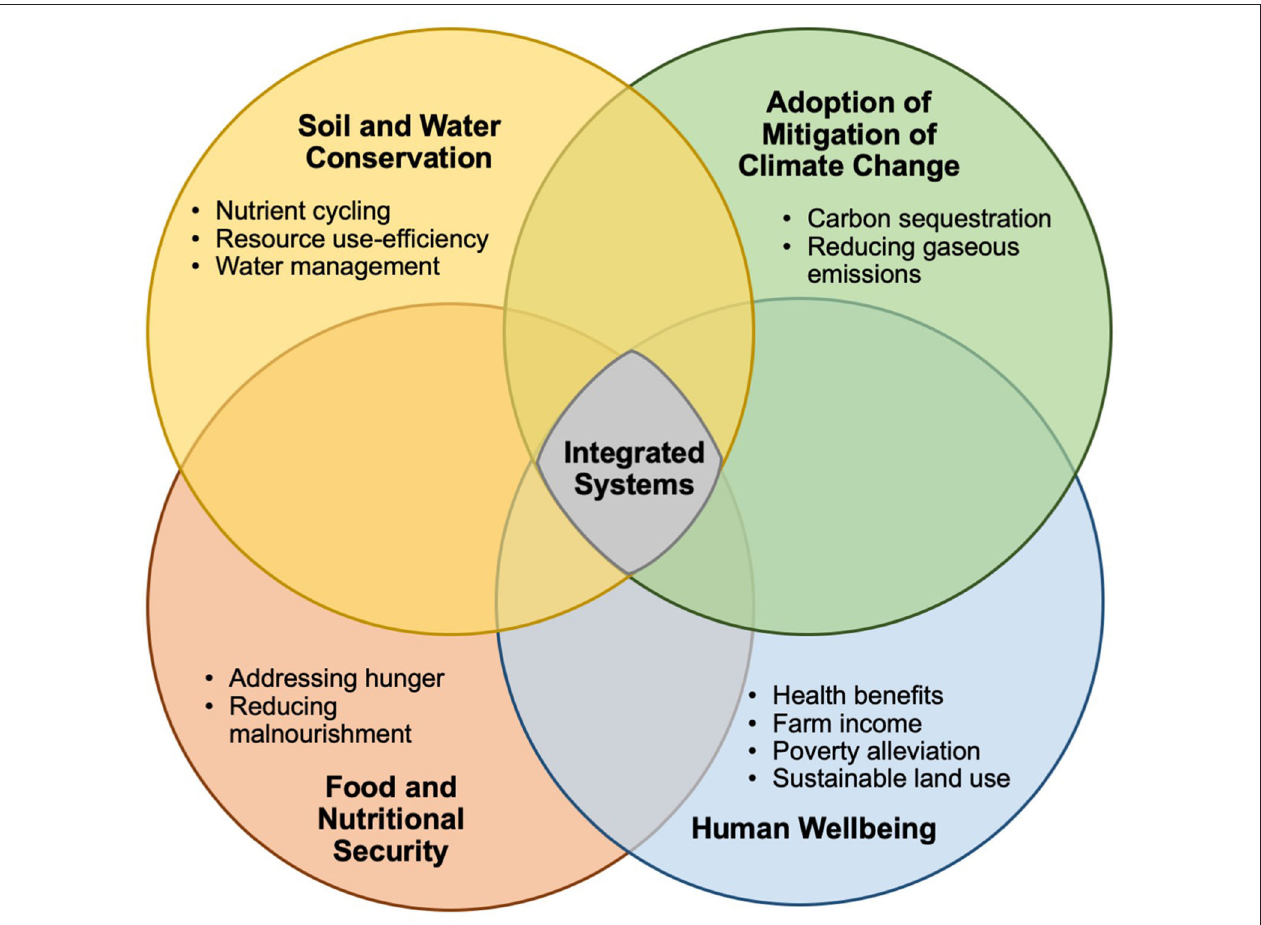
FIGURE 4 | Ecological and socio-economic benefits of integrating livestock with crops and